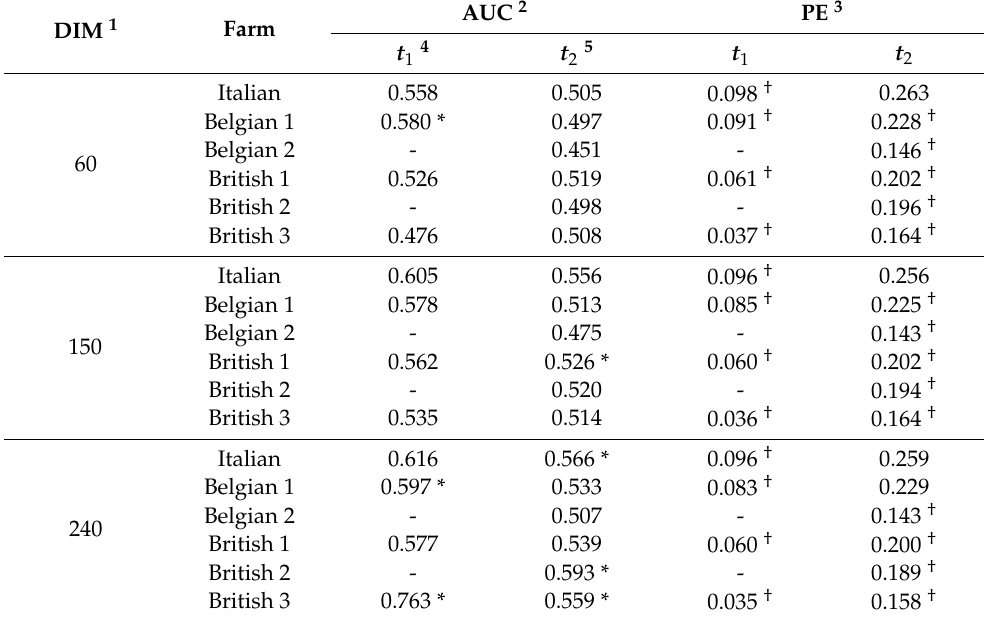
Table 4. Predictive accuracy measures of the algorithm.